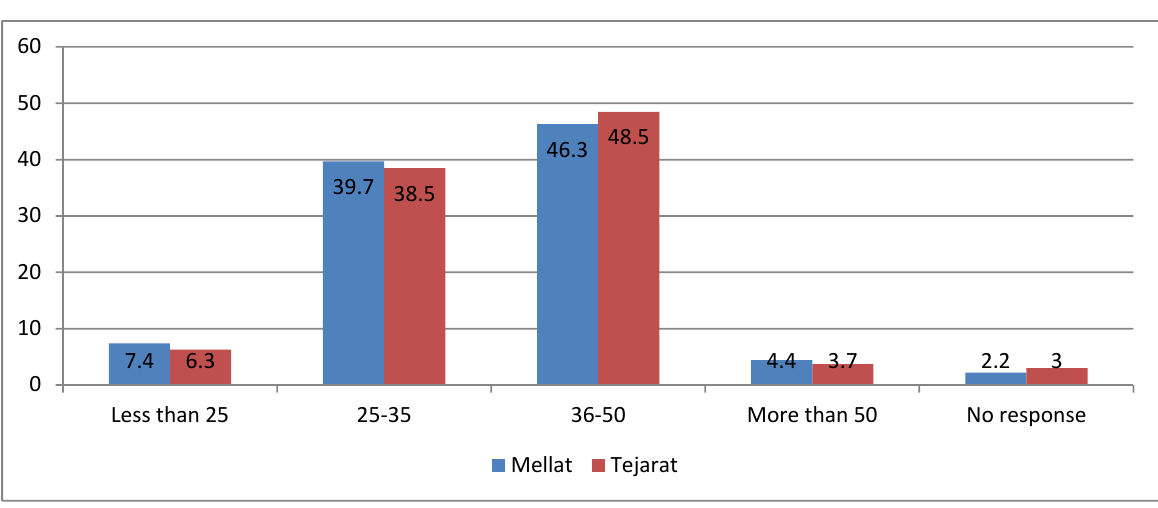
Fig. 1. Frequency of participants’